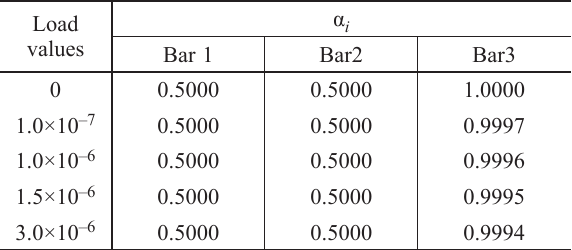
Table 7. Results of a three-bar pin-jointed structure